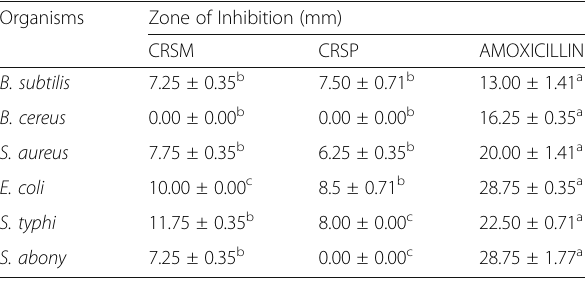
Table 5 Antimicrobial activity of methanol and petroleum ether extracts of C. renigera seed in disc diffusion method Organisms